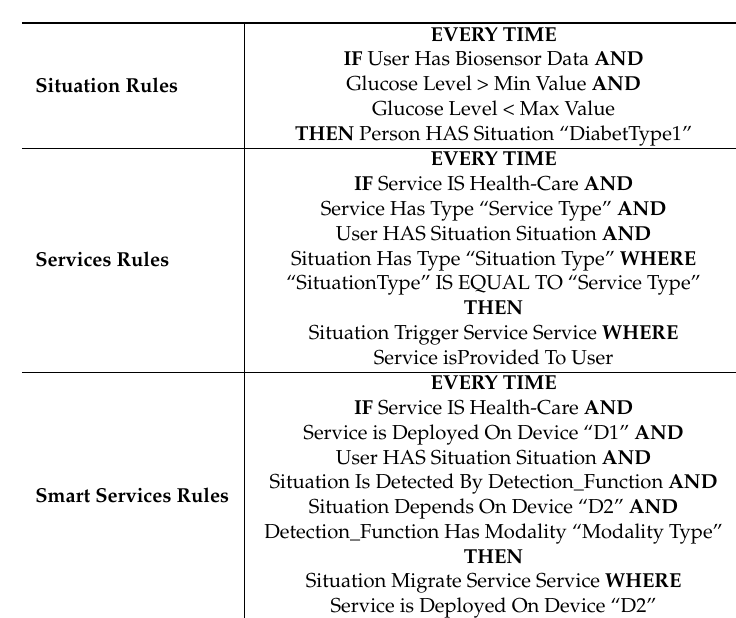
Table 2. Examples of the